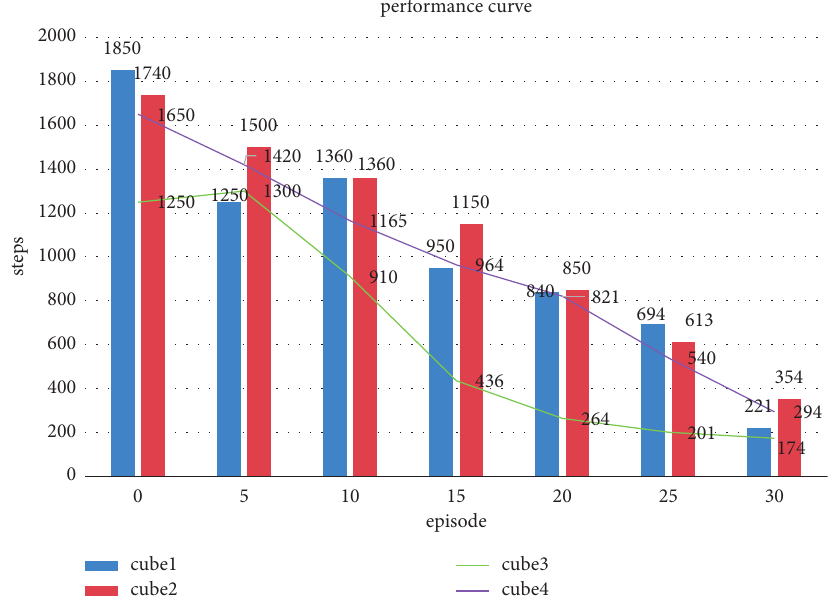
Figure 7: The experimental results and performance curve of the agent looking for the target.